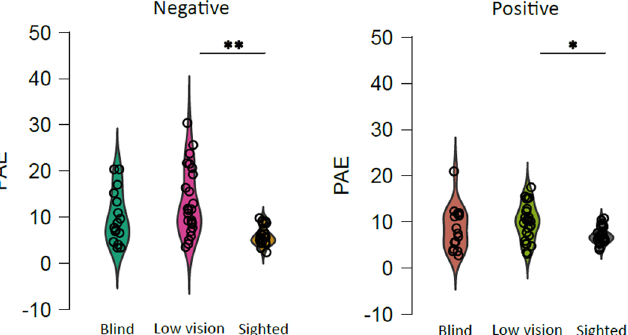
Figure 3. Effect of visual experience and task condition on number-to-position unsigned error. The performance of blindfolded sighted (white), low vision (grey), and congenitally blind (black) children was analyzed in terms of the Percentage of Absolute Error (PAE) representing the absolute deviation to the true number’s position. The graphs indicate that the low vision group differed from the sighted group when asked to localize positive and negative numbers on the rule independently of the spatial plane (horizontal or vertical) considered. The violin plot element shows the density and distribution of the data. Data points represent mean data for each participant. Significant comparisons are highlighted by asterisks (* p < .05; ** p <